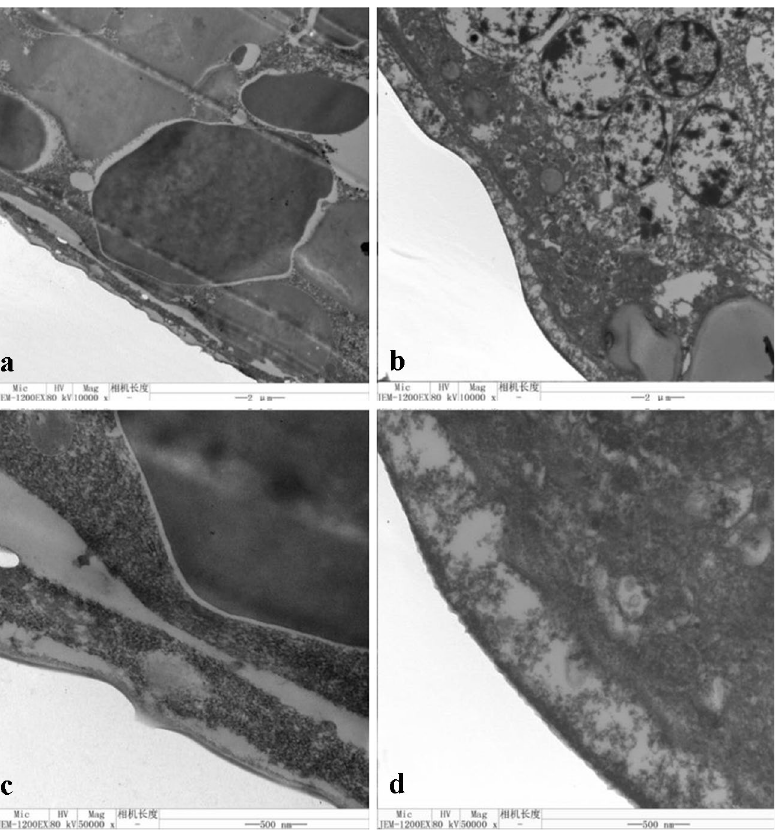
Figure 9. The effect of spirotetramat on the structure of F. occidentalis 0-h-old eggs. ( a ) and ( b ) 0-h-old eggs in the control treatment; ( c ) and ( d ) 0-h-old eggs in the spirotetramat